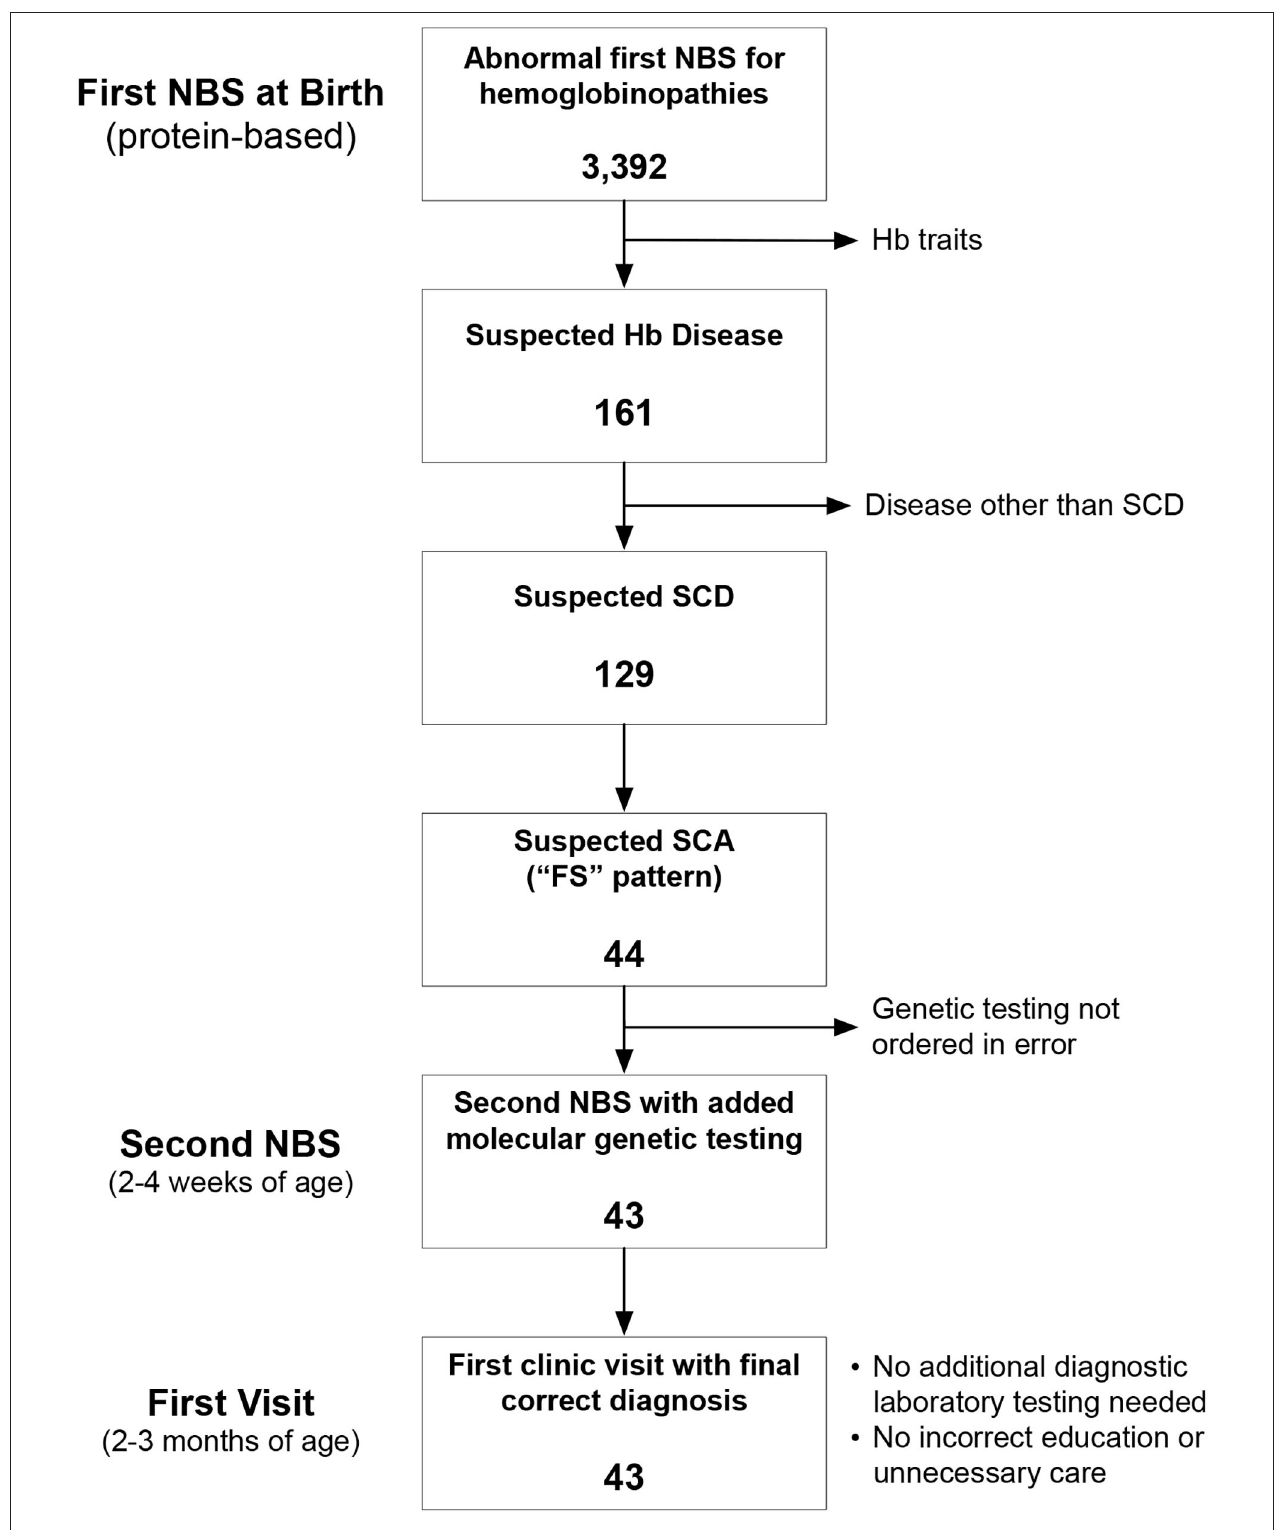
FIGURE 1 | Identification of the study cohort. Between July 2015 and December 2020, there were 3,392 abnormal newborn screening (NBS) tests for hemoglobinopathies. We excluded newborns with hemoglobin (Hb) trait states and hemoglobinopathies other than sickle cell disease (SCD). We identified 44 newborns during this time with an “FS” pattern, indicating suspected sickle cell anemia (SCA), which we define here to include both homozygous sickle cell anemia (HbSS) and sickle- β 0 -thalassemia (HbS β 0 ).